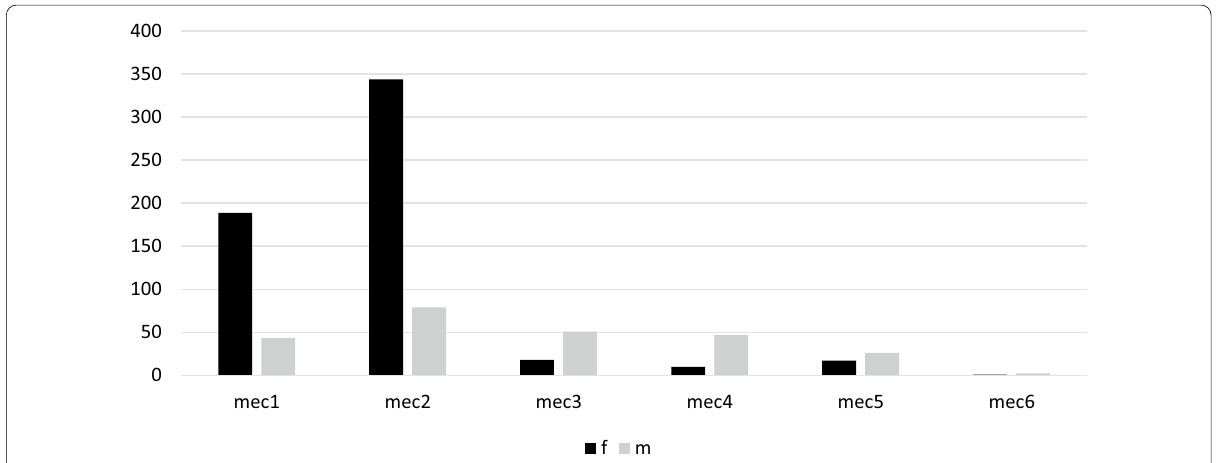
Fig. 3 Distribution of DRFs in both genders according to the different trauma mechanisms. M, male; F, female. DRFs, distal radius fractures; Mec 1, low-energy trauma that occurred in a public place; Mec 2, low-energy trauma that occurred at home; Mec 3, sports trauma; Mec 4, high-energy trauma resulting from car and pedestrian accident; Mec 5, work-related injuries; Mec 6, trauma resulting from assault, beatings, or theft